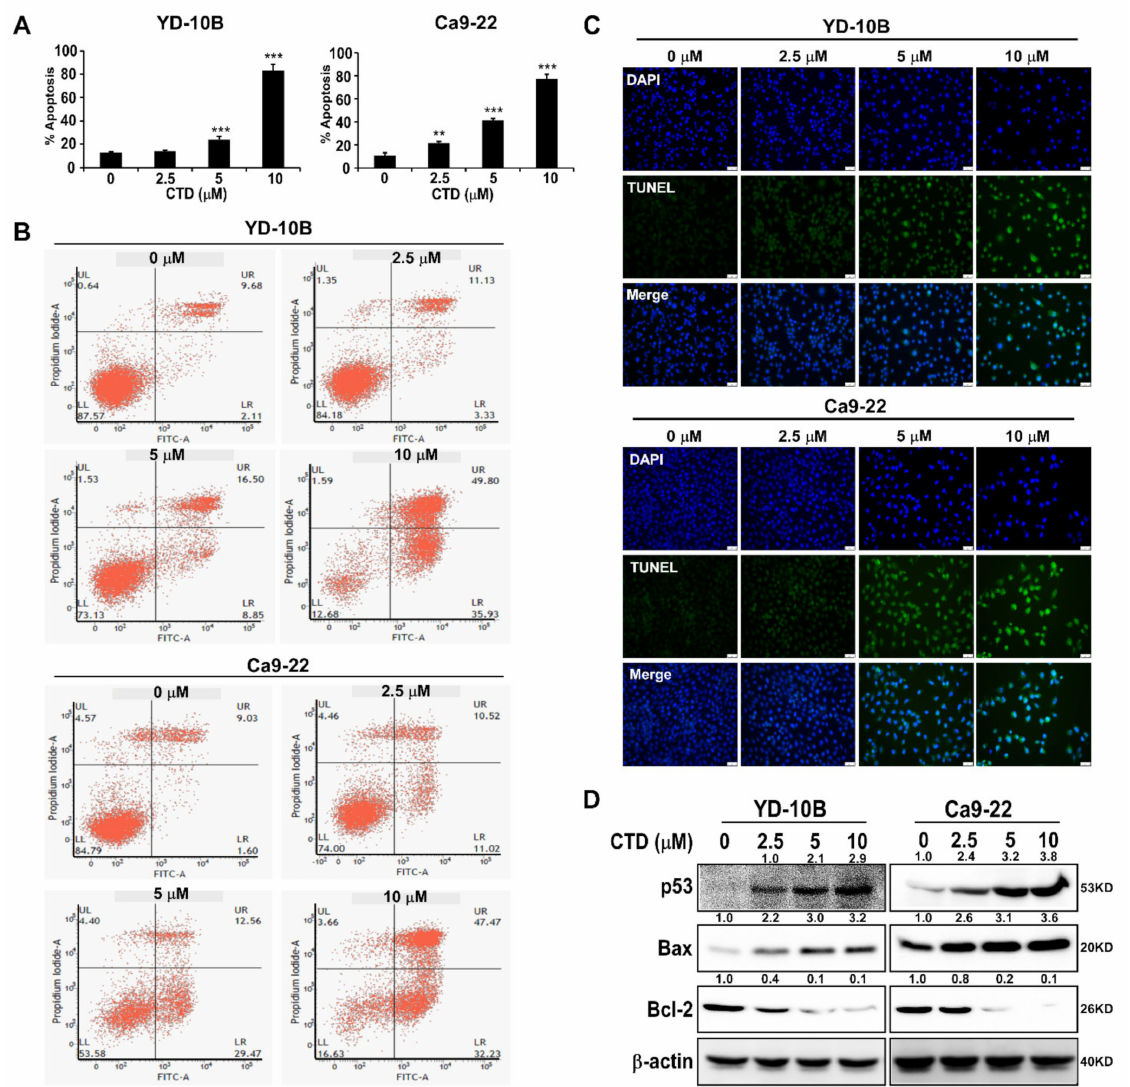
Figure 6. Costunolide triggers apoptosis of oral cancer cells. ( A ) Analysis of the results of apoptosis assay. Data are expressed as mean ± SD of values from triplicate samples. ** p < 0.01 and *** p < 0.001 indicate a significant difference compared with control. ( B ) Image of apoptotic cell populations. ( C ) The apoptosis of indicated cells treated with or without CTD at different concentrations (0, 2.5, 5 or 10 µ M) was measured by TUNEL assay (Scale bar = 200 µ m). ( D ) Expression of apoptotic markers in oral cancer cell lines. Cells were treated with 0, 2.5, 5 or 10 µ M CTD and then incubated for 24